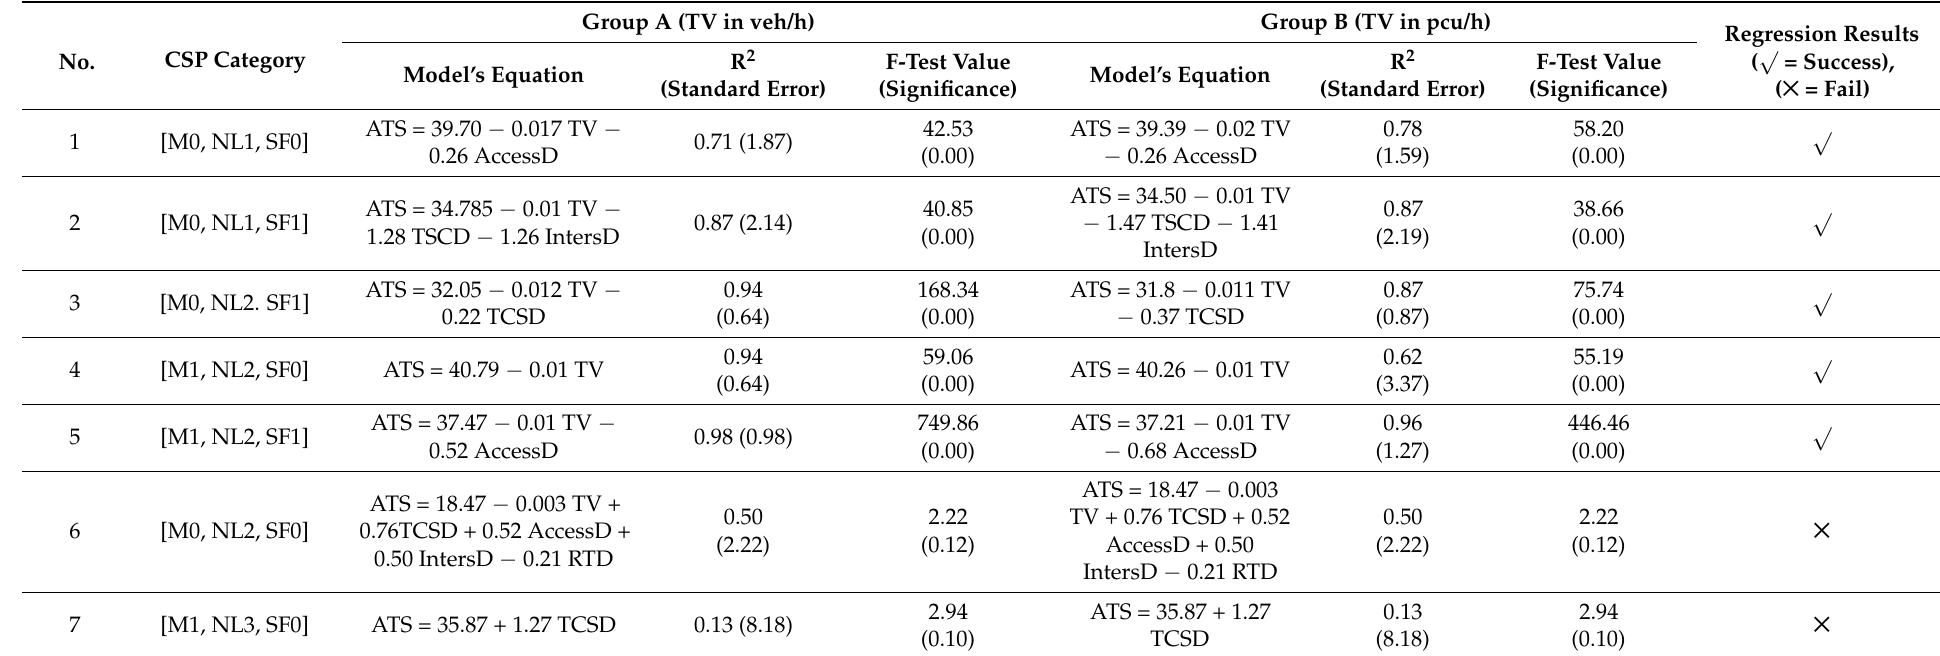
Table 5. Developed models for two terms of traffic volume (veh/h, and